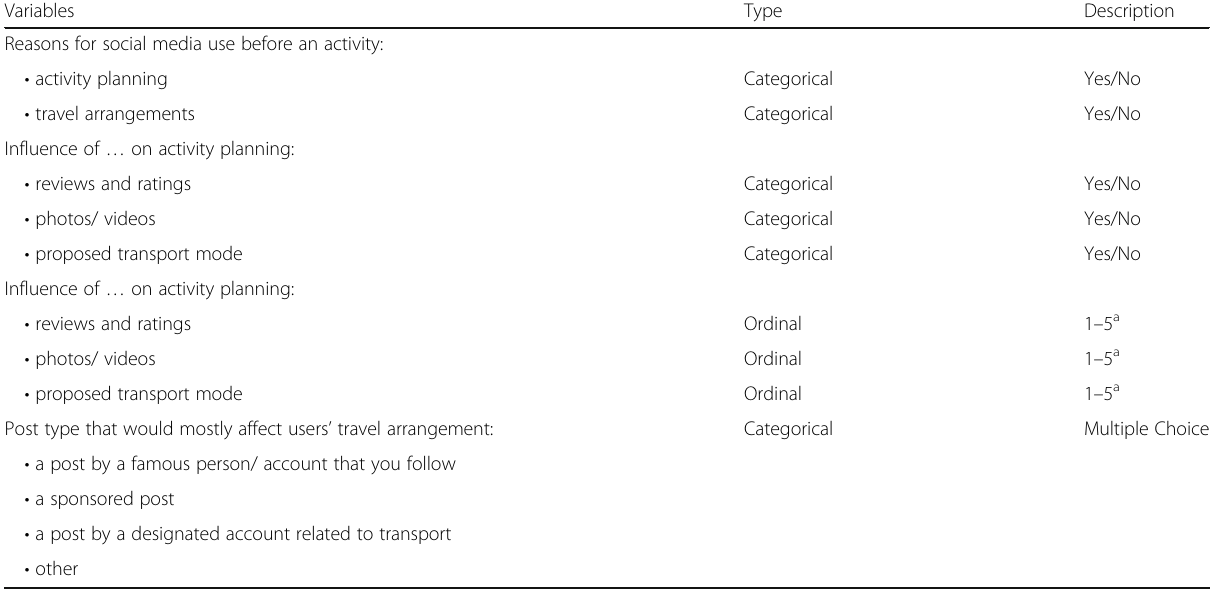
Table 1 List of tested variables before an activity